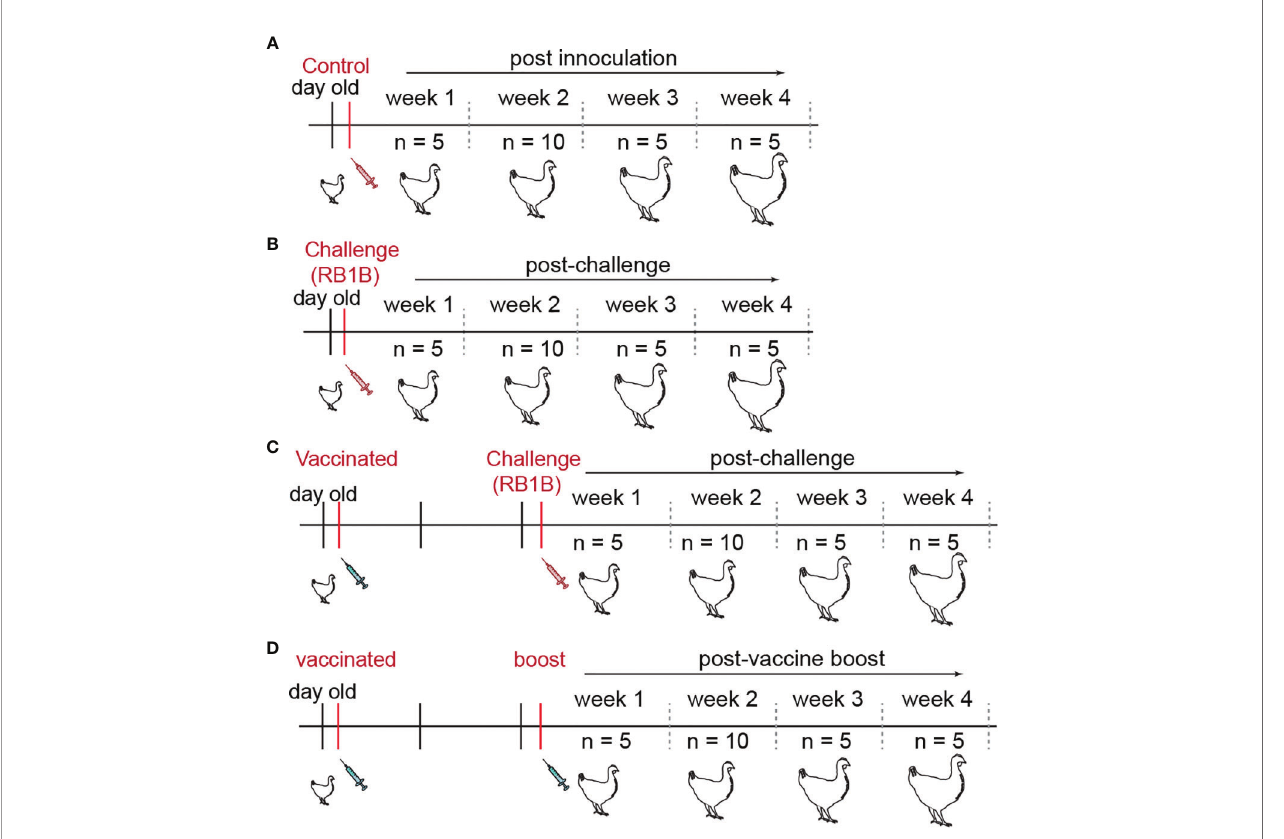
FIGURE 1 | Chicken infection models developed to study T cell mediated immune responses. Schematic representation of experimental design to study cell mediated immune response to MDV in both line N (n = 100) and line P2a (n = 100) chickens. Day old chickens were administered with (A) non-infected chicken embryonated fi broblasts (control group; n = 25), (B) virulent MDV (RB1B; 1,000 PFU/chicken) (challenge group; n = 25), or vaccine strain of MDV (CVI988/RISPENS; 1,000 PFU/chicken). The latter group were either (C) infected with the virulent MDV (vaccine-challenge group; n = 25) or (D) boosted with the MDV vaccine two weeks later (vaccine-boost group; n = 25). The birds were sacri fi ced on weeks 1, 2, 3, and 4 post the last inoculation and the frequencies of IFN-gamma producing virus-speci fi c T cells were